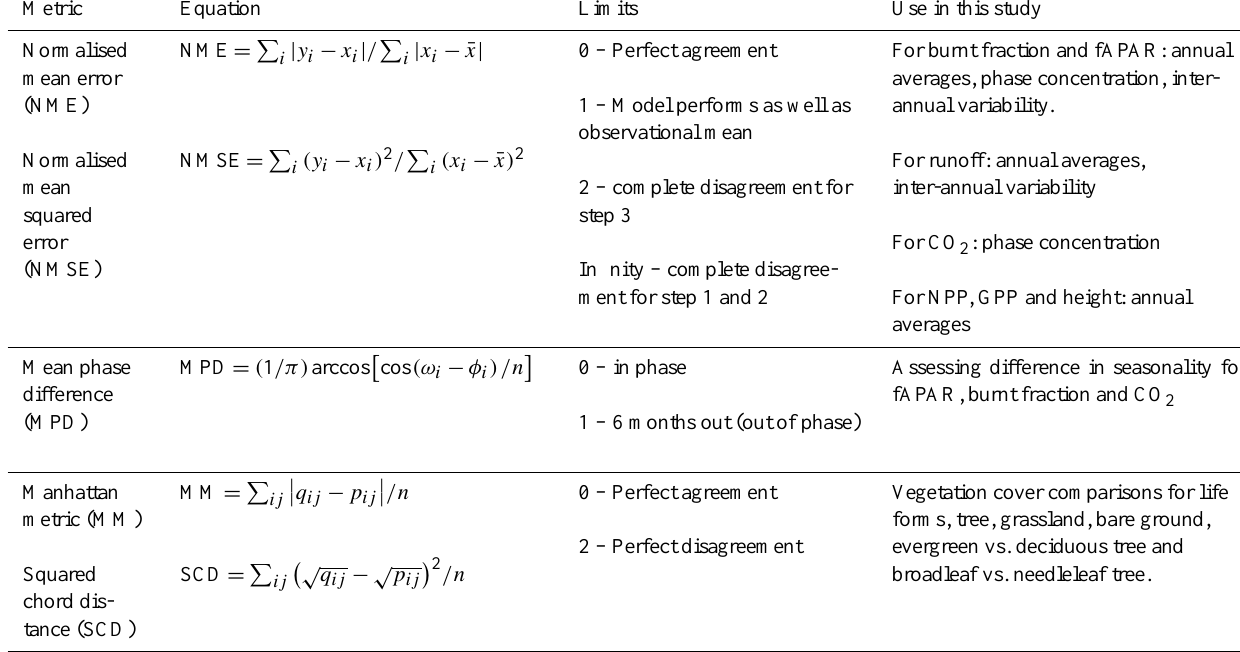
Table 2. Summary description of the benchmark metrics. y i is the modelled and x i is the corresponding observed value in cell or site i , and ¯ x is the mean observed value across all grid cells or sites. ω i is the modelled phase, and ϕ i is the observed phase. q ij is the modelled and p i observed proportion of item j in cell or site i .